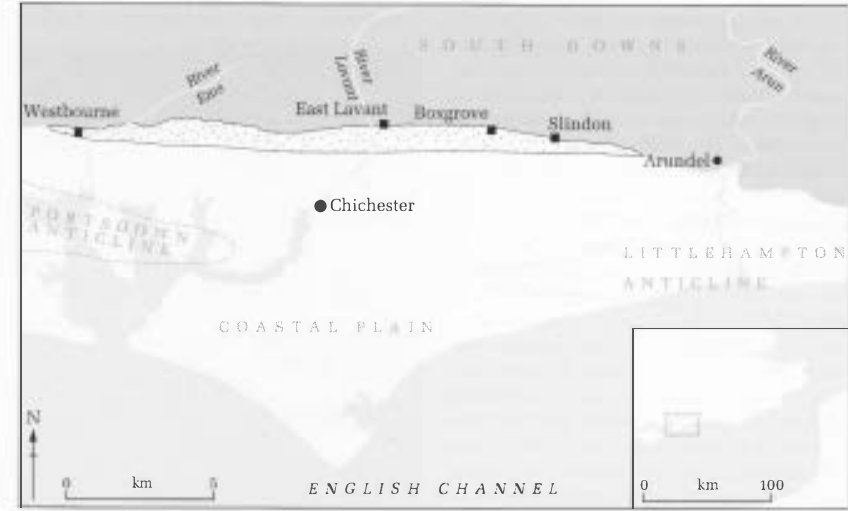
Figure 1 Location of the Lower Palaeolithic (Middle Pleistocene) site of Boxgrove, West Sussex, and of other Lower Palaeolithic sites mentioned in the text. The stippled area represents the deposits of the Boxgrove raised